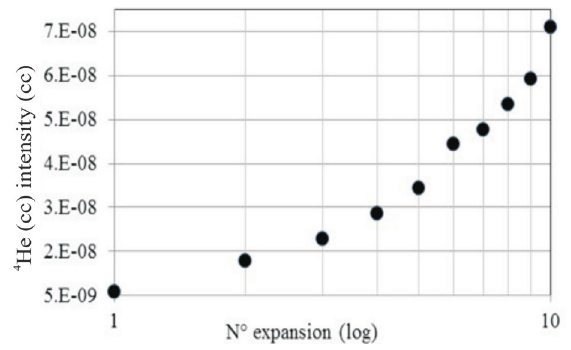
Figure 3 - Plots showing the expansion experiment using 10 shots of he from the standard